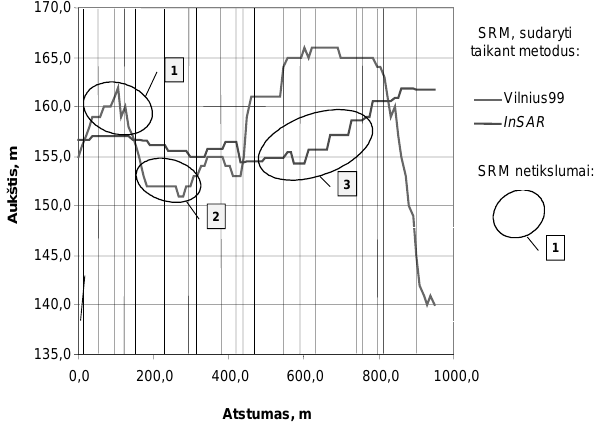
Fig 2. DTM, created using InSAR method analysis Palyginus InSAR metodu sudaryt ą SRM su Vilniaus teritorijoje fotogrametriškai išmatuotomis tašk ų